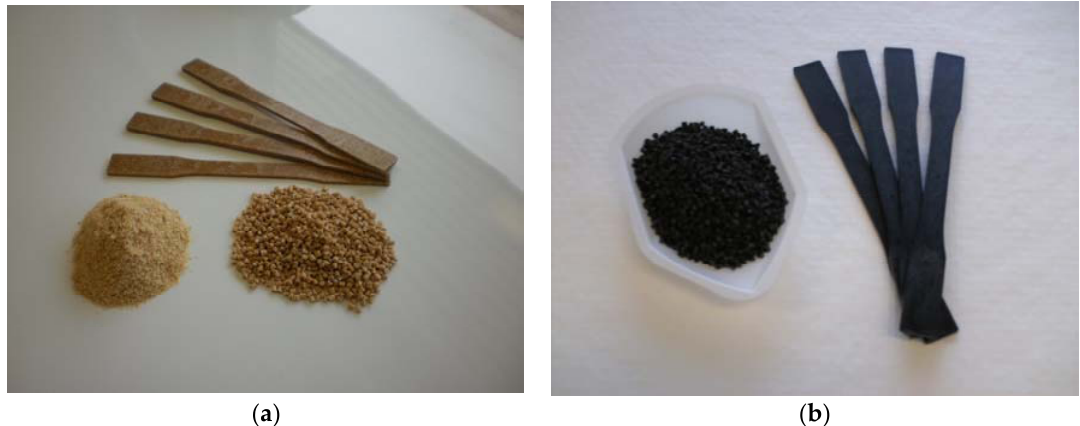
Figure 1. Images of HDPE composite pellets and tensile samples from untreated wood ( a , wood polymer composites, WPC) and biochar ( b , Biochar polymer composites, BPC). Table 1. Injection molding machine parameters.